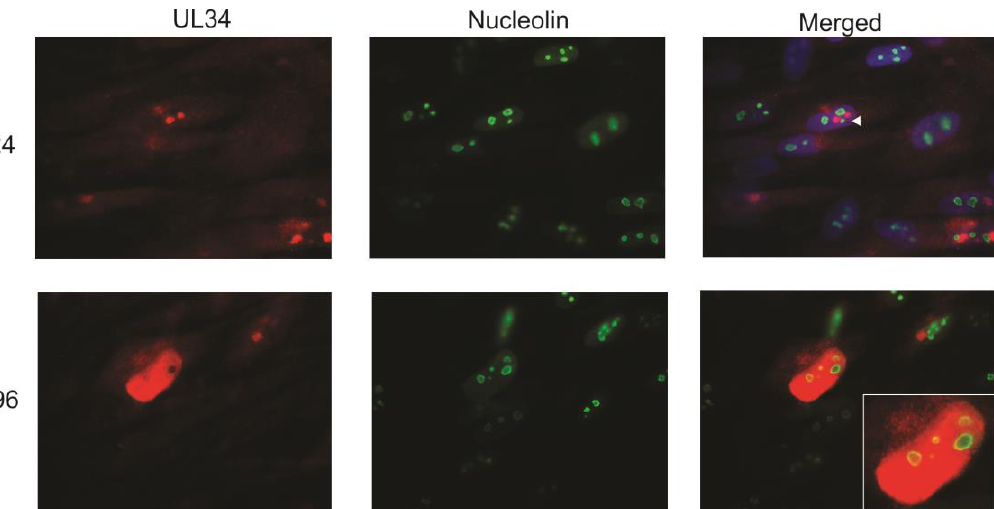
Figure 5. Indirect immunofluorescence was performed on primary human fibroblasts infected with HCMV strain Towne at 24 and 96 hpi using antibodies to UL34 and to nucleolin. UL34 staining is red, nucleolin staining is green; the green and red images were merged with the DAPI-stained images (blue) in the merged column at 24 hpi as described for Figure 1; the DAPI-stained image was not included in the merged image for the 96 hpi timepoint. The arrowhead indicates the association of UL34 with nucleolin early in infection. The inset shows an enlargement of the colocalization of UL34 and nucleolin at 96